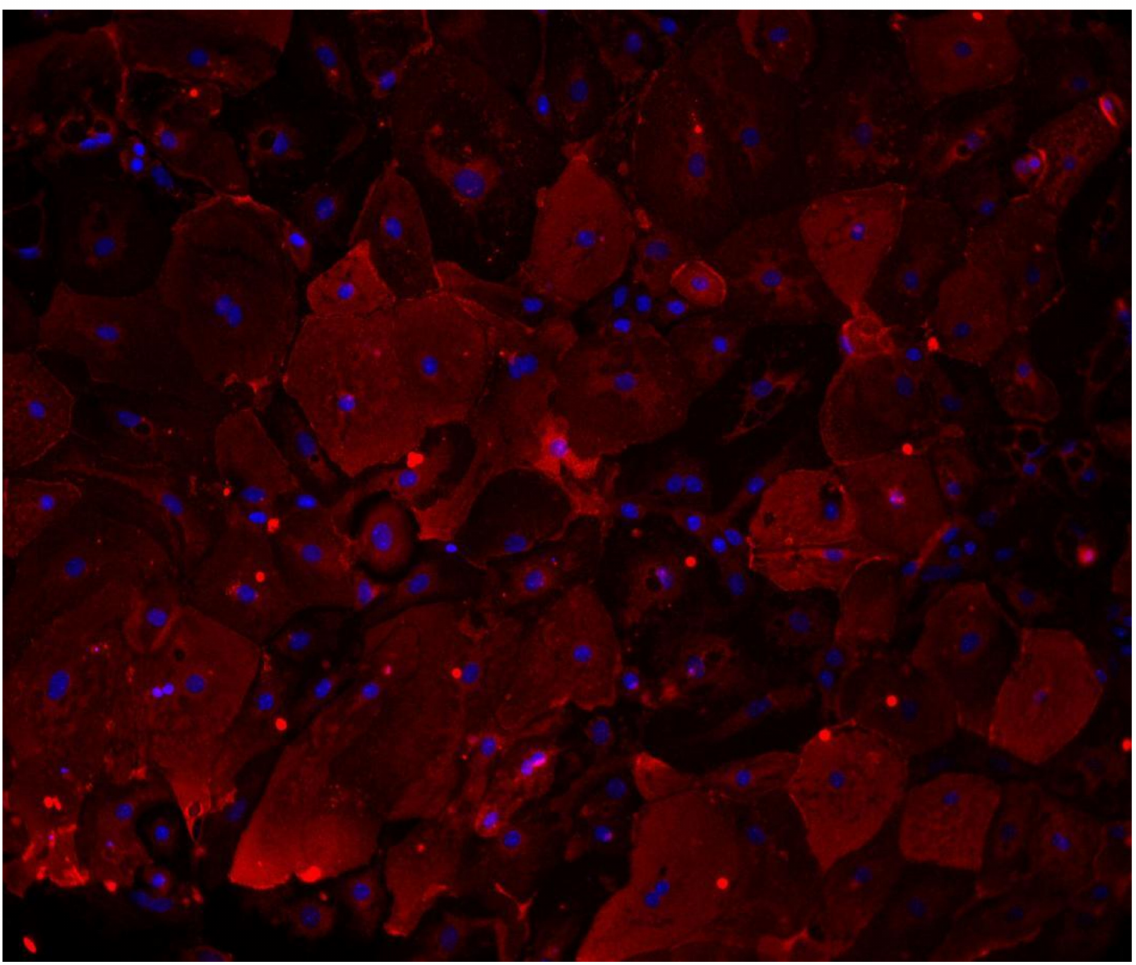
Figure 2. Trans-differentiation of Alveolar type II cells into Alveolar type I (ATI) cells in culture. A representative image of isolated human alveolar type II cells differentiated into alveolar type I cells after 8 days in culture. ATI cells are large and flat cells and occupy 95% of the alveolar compartment. After isolation. The cells were seeded in primary 96-well plates coated with collagen type II in PneumaCult medium, enriched with 1% Pen/Strep. The cells were harvested after 8 days, without FBS, so as to promote trans-differentiation in vitro. The cells were washed with PBS after 8 days in culture and fixed for the specific marker of AT1 cells, Rage (red). There was no evidence of Surfactant Protein C expression (green) after 8 days in culture. The cell nuclei were identified in Blue, using Hoechst staining. The image was acquired by a Nikon Eclipse Ti-E inverted fluorescent microscope, equipped with DC-152Q-C00-FI using NIS V4.30 software (Nikon). Scale bar 100